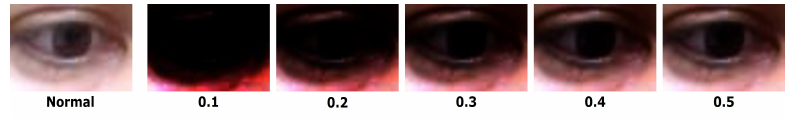
Figure 4. Examples of gamma-corrected images.